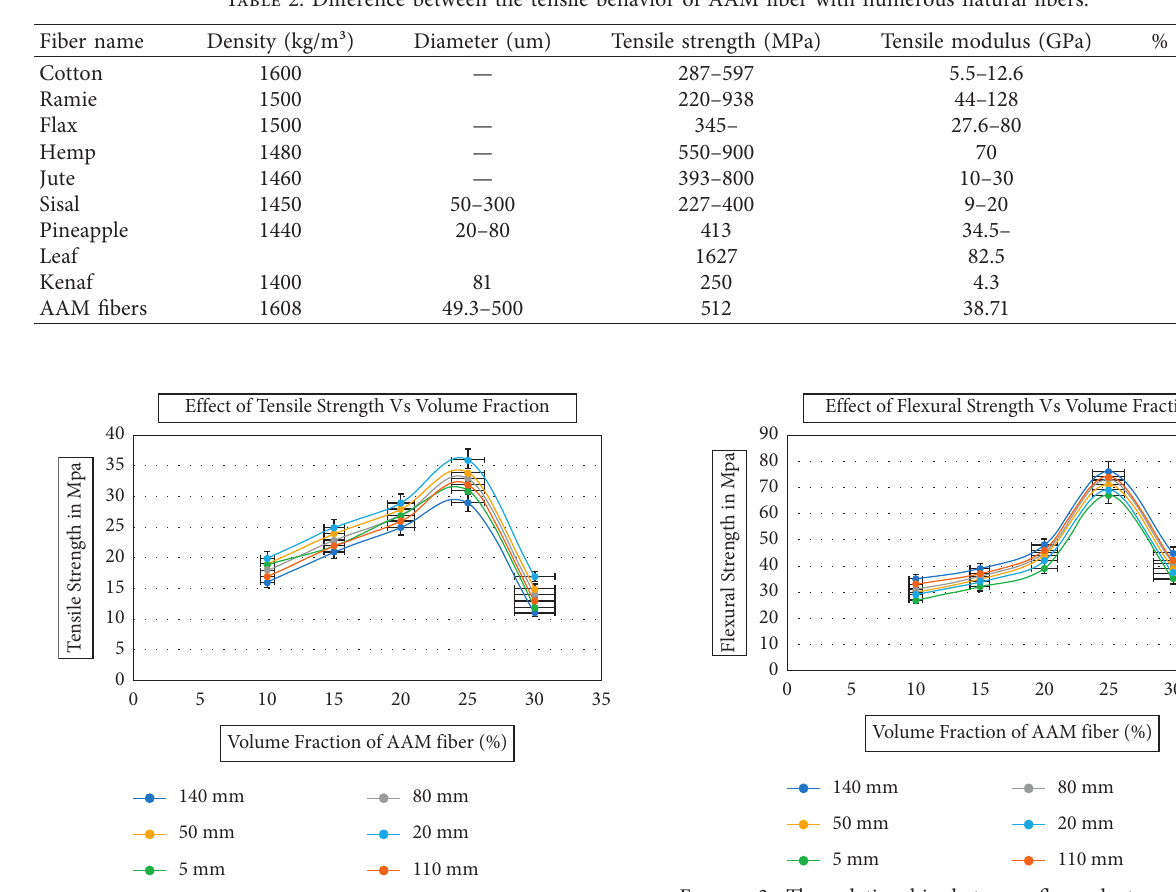
Figure 1: Effect of Tensile strength versus volume fraction of AAM fiber through different fiber lengths.